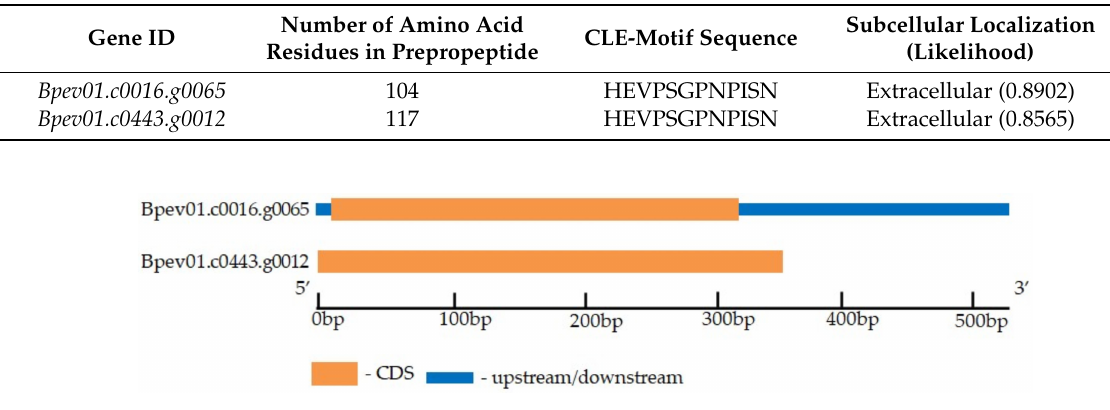
Figure 4. The structure of the B. pendula CLE41/44 genes. The exon and untranslated region (UTR) are represented by orange boxes and blue boxes,